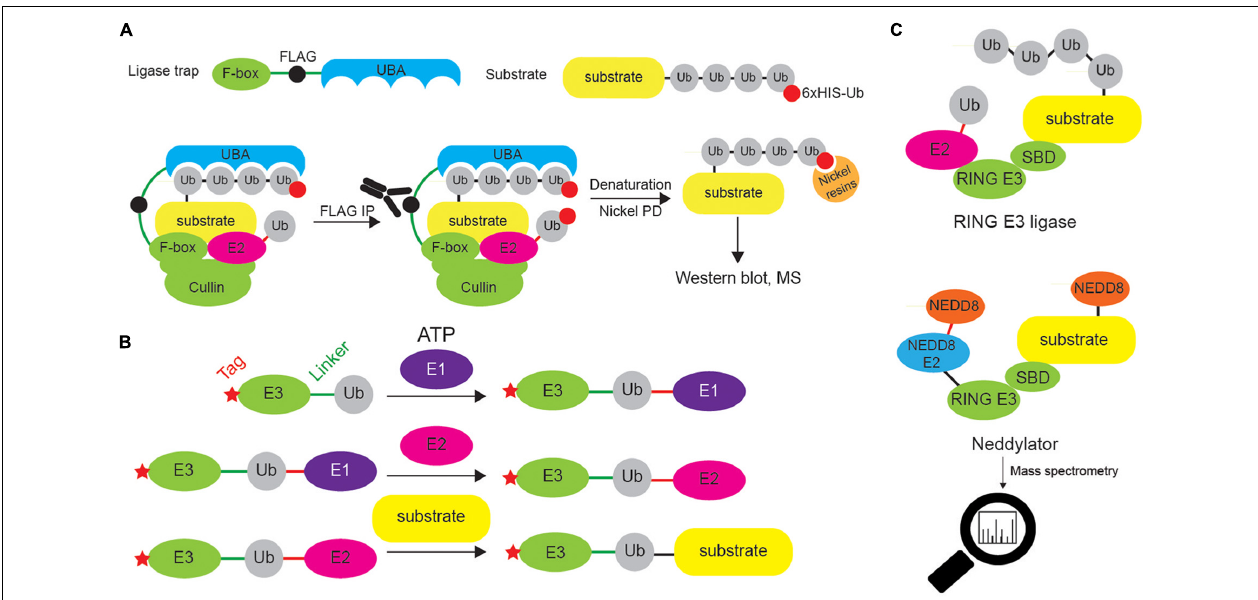
FIGURE 9 | Different approaches to identify E3 ligase substrates. (A) Ligase trapping approach “stabilizes” E3 ligase:substrate non-covalent interactions by UBDs (such as UBA domain) fused to E3 ligase substrate-interacting domains (such as F-box of the multi-protein E3 ligase complex SCF). When such ligase traps and 6xHIS-tagged Ub are overexpressed in cells, the UBA interacts with the nascent Ub chain on endogenous SCF substrates, thereby delaying their release. Cells are then lysed and subjected to an anti-FLAG coimmunoprecipitation under native conditions, to isolate ligase trap complexes (FLAG tag is inserted between F-box and UBA). FLAG eluates are then used in denaturing Ni-NTA agarose pull-down to exclusively enrich ubiquitinated substrates (and to remove any non-covalently interacting proteins). (B) UBAITs, similar to ligase traps, enable identification of E3 ligase substrates (for both HECT and RING E3 ligases), as well as their adaptors and regulators. Unlike ligase traps, UBAITs are fusions of N-terminal affinity-tagged E3 and C-terminal Ub molecule. With the help of cellular E1 and E2, UBAIT E3 component transfers UBAIT Ub component (by forming amide bond) to proteins that interact with the E3, such as E3 ligase substrates. Formed complex is easily affinity purified and analyzed by mass spectrometry. For HECT E3s, both E3 and E2 thioester-linked interacting proteins can be captured by UBAITs. (C) NEDDylator is a catalytic tagging tool, in which Ubc12, an E2 enzyme for NEDD8, is fused to an E3 ligase substrate-binding domain, allowing for the transfer of NEDD8 to the E3 substrate, and MS-based identification of E3 ligase-target